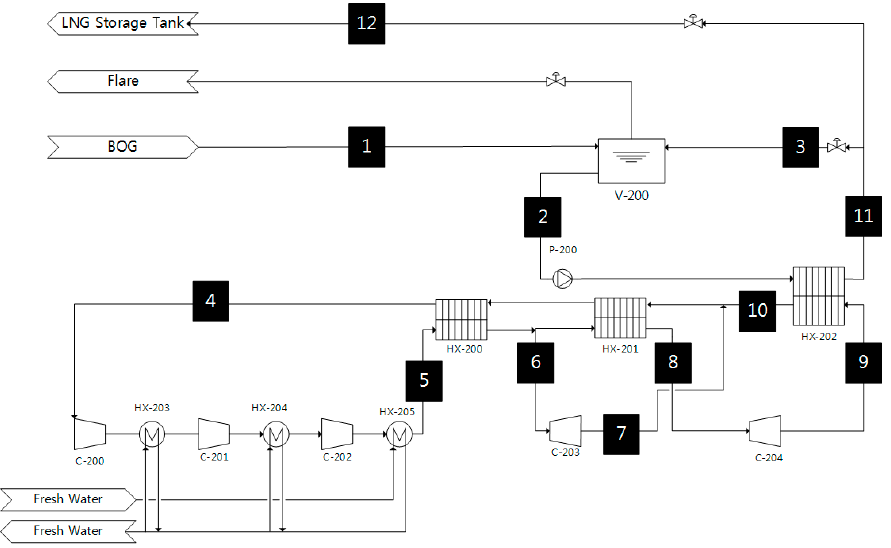
Figure 2. Process flow diagram of System II.